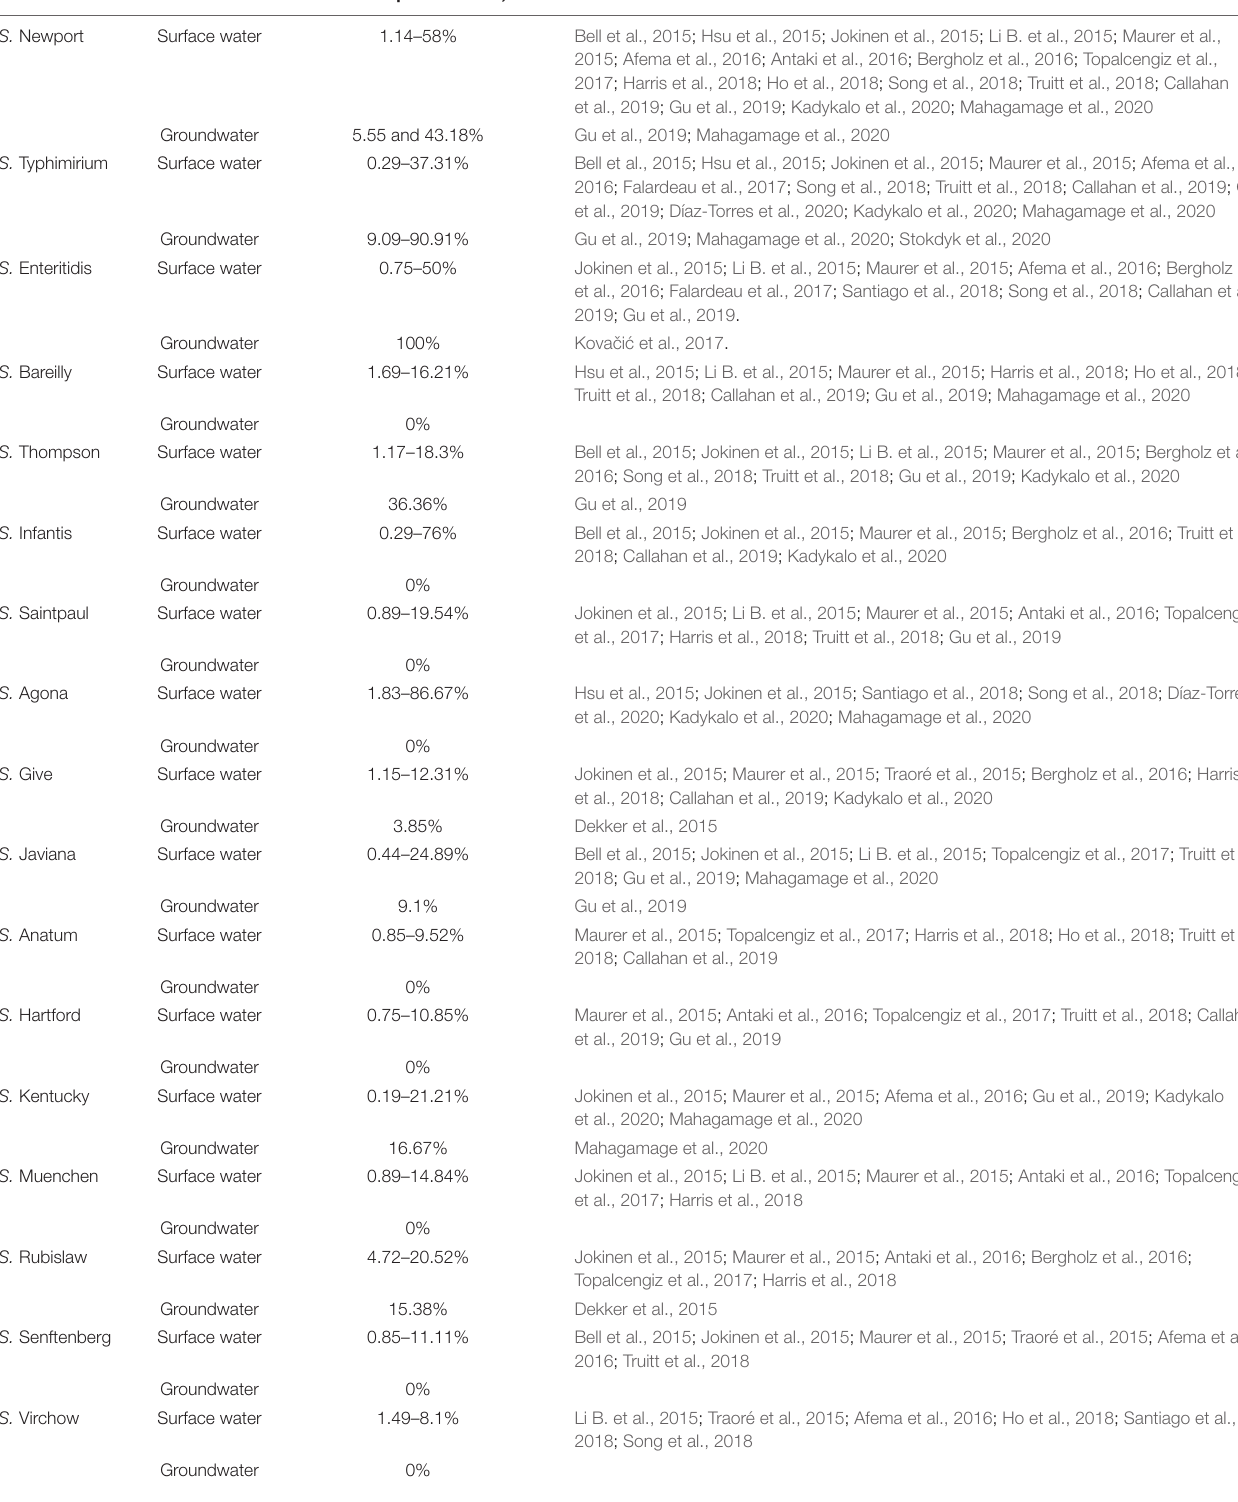
TABLE 1 | Relative representation of Salmonella enterica serovars associated with surface and groundwater sources that have been reported in peer-reviewed scientific publications addressing the occurrence of Salmonella in aquatic environments between the years 2015 and 2020 (Only serovars reported in at least five different studies are